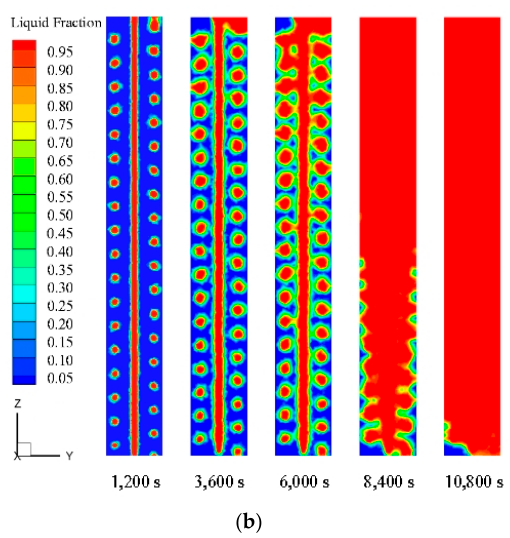
Figure 10. Tempertaure distribtion and liquid fraction of the TES unit over time for Case B. ( a ) Temperature distribution of the outer surface; ( b ) Liquid fraction of the vertical section.